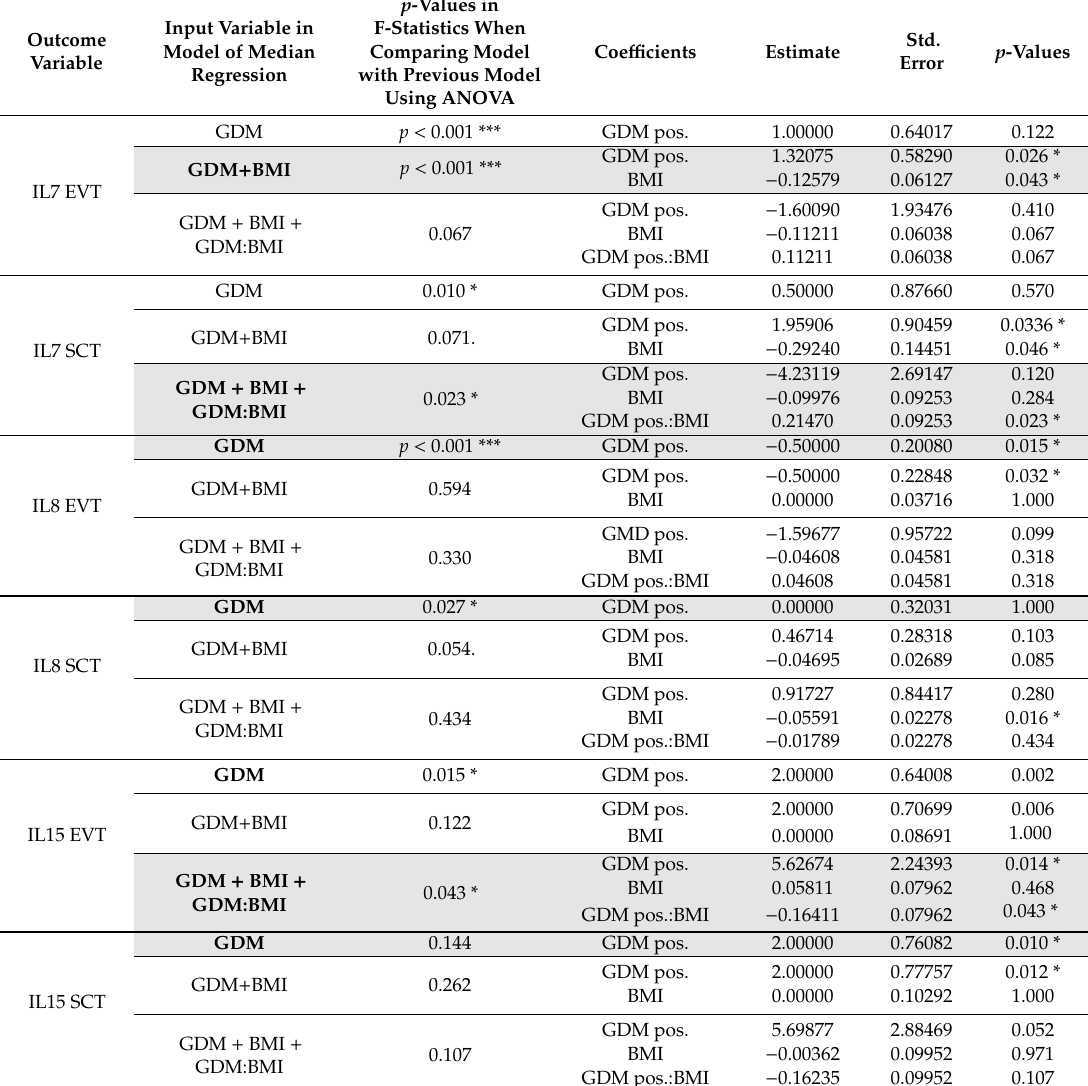
Table 2. Linear Median Regression Models for Interleukin Expression Including BMI and